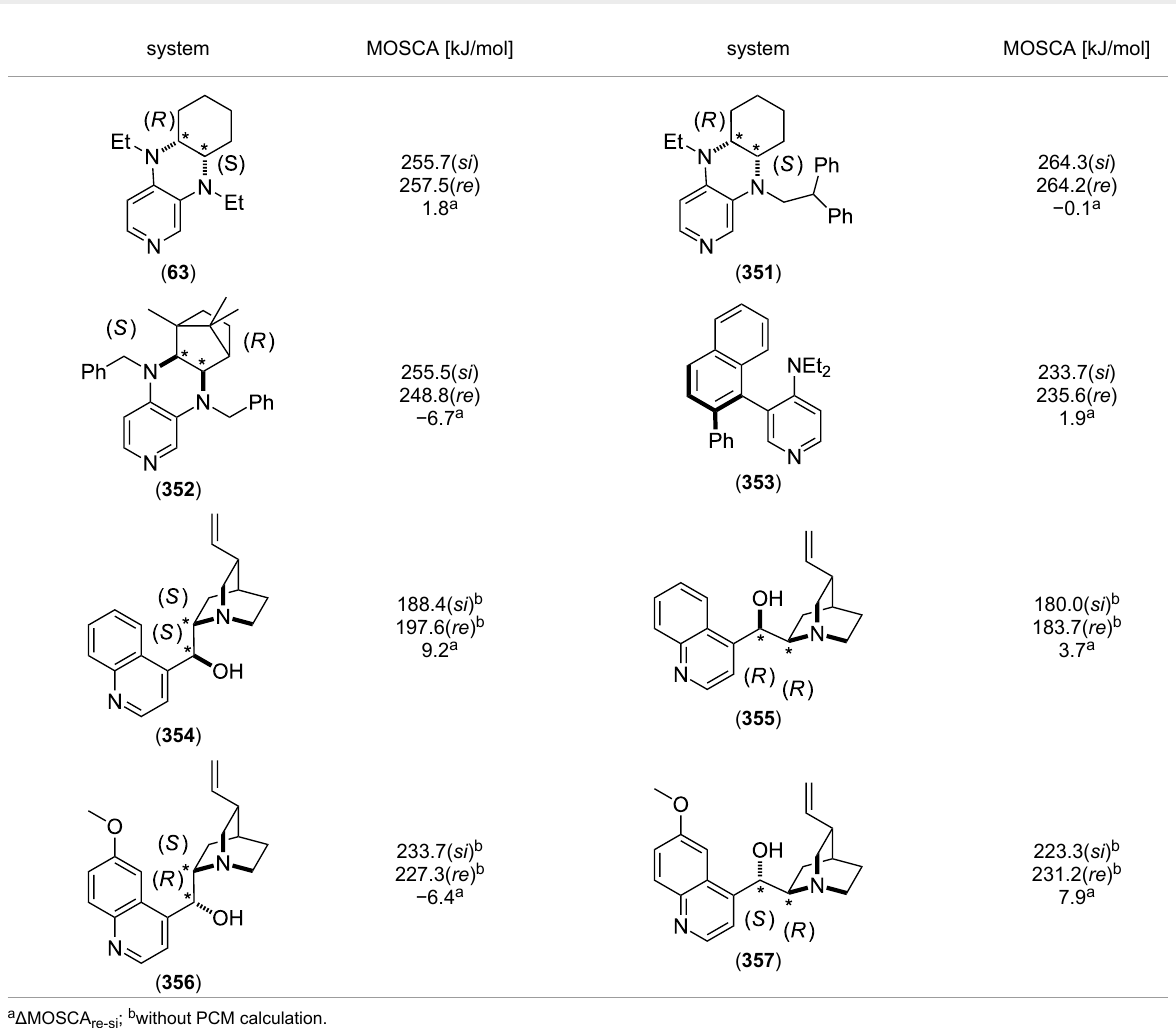
Table 12: MOSCA values of chiral Lewis bases, ordered by increasing MCA values.